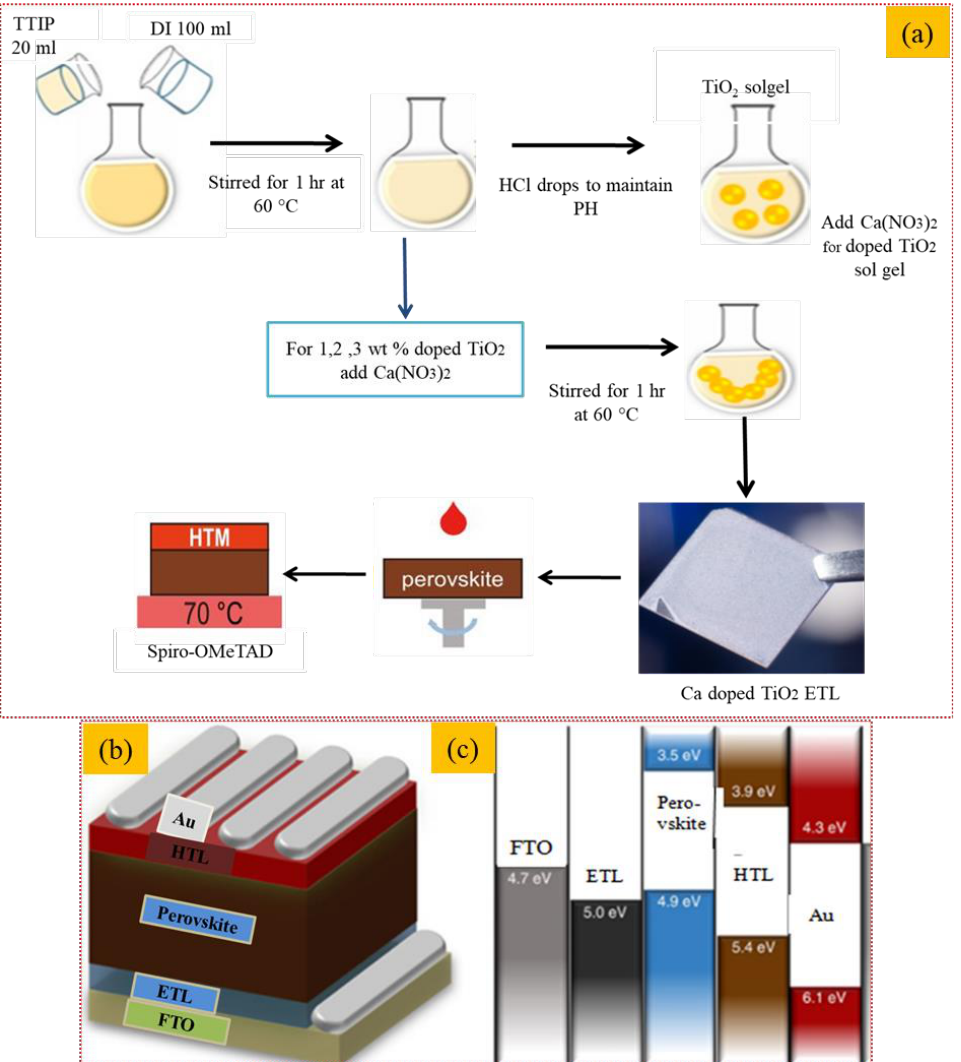
Figure 1. Sol-gel formation and thin film deposition of Ca-doped TiO 2 thin films; ( a ) synthesis of doped and undoped TiO 2 and perovskite solar cell fabrication ( b , c ) Schematic of perovskite solar cell fabrication.